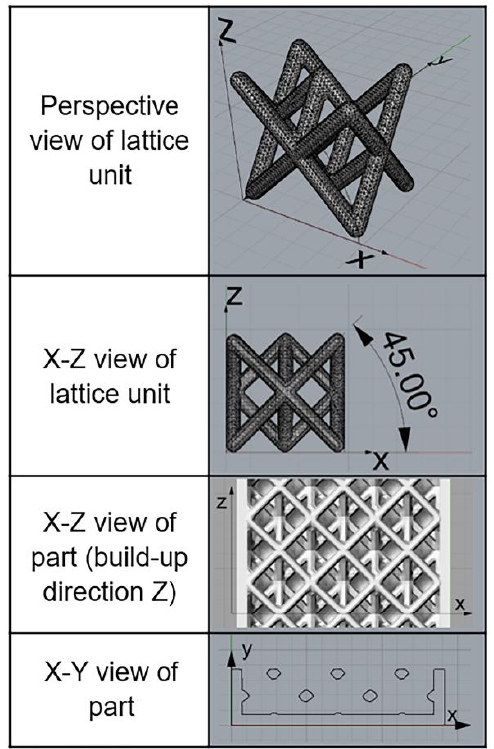
Figure 1. Lattice design and the 3D spatial arrangement of the selective laser melting process.